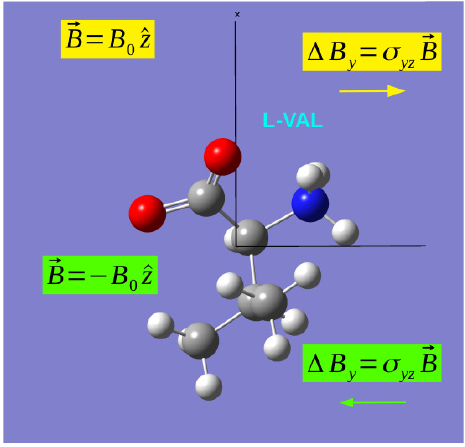
Figure 1. The shift in local magnetic field for L-valine for a magnetic field in the positive and negative z-direction. For D-valine, the shift in the magnetic field is in the opposite direction.